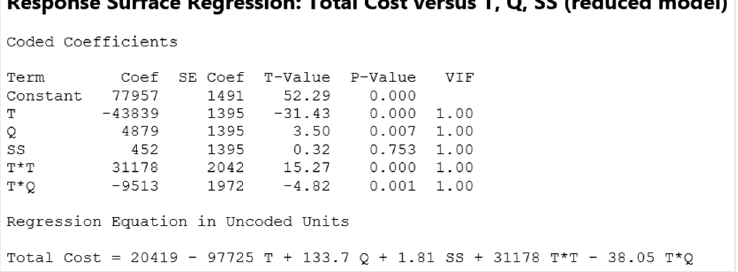
Figure 17. BBD—response surface regression of TC versus T, Q, and SS (reduced model).